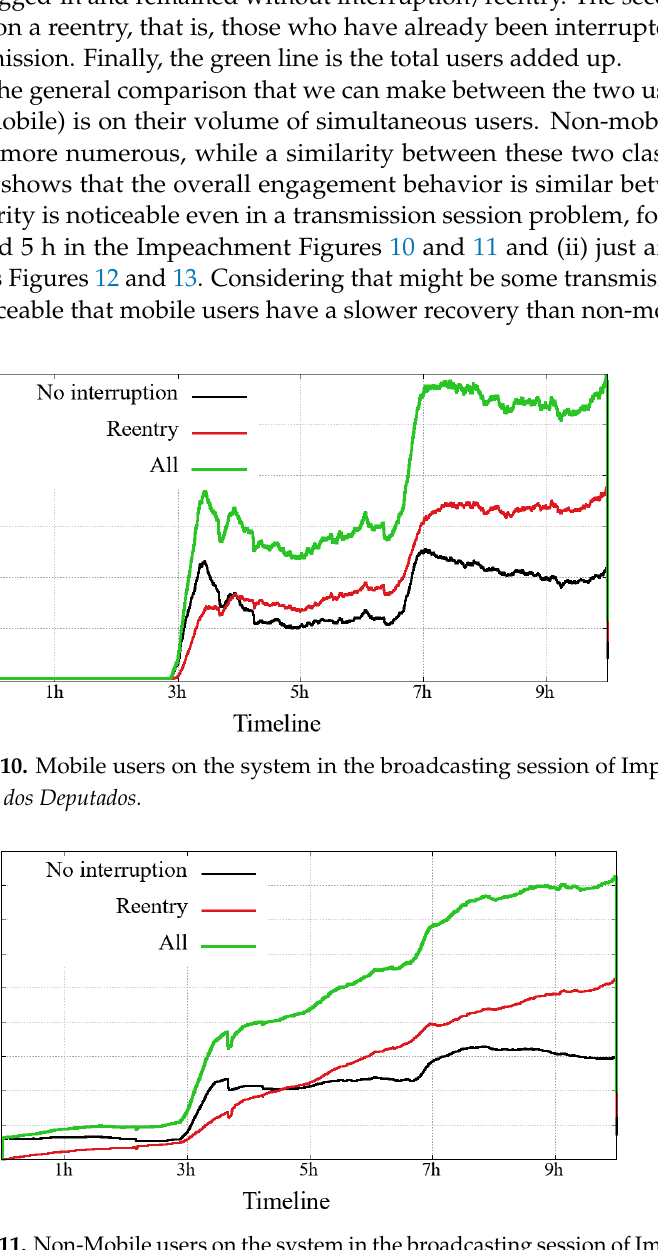
Figure 11. Non-Mobile users on the system in the broadcasting session of Impeachment start session— Camara dos